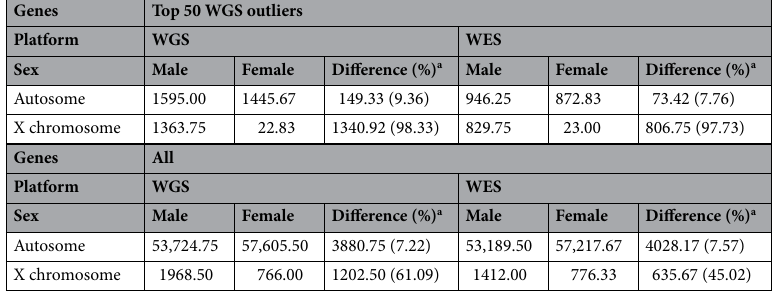
Table 5. Mean SNVs per individual for ten WES and WGS cats. a Percentage differences in parentheses were calculated as a fraction of mean SNVs per male individual.